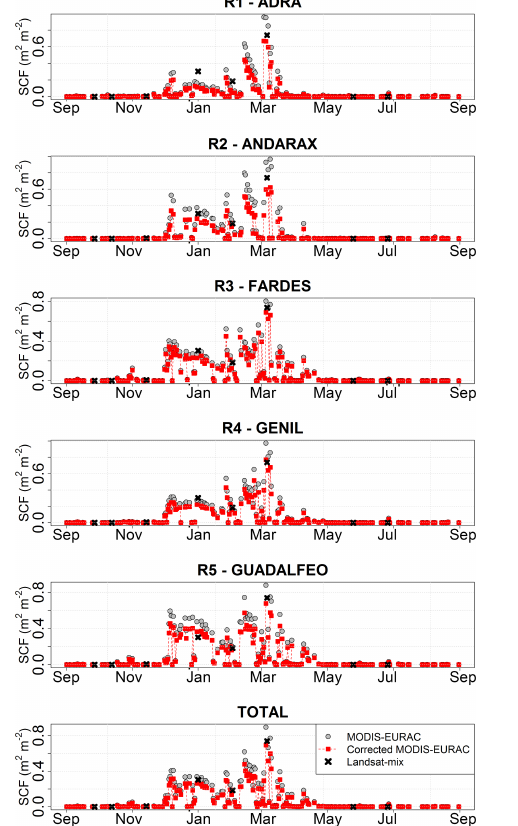
Figure 4. Example of reconstruction of MODIS-EURAC snow cover map for the year